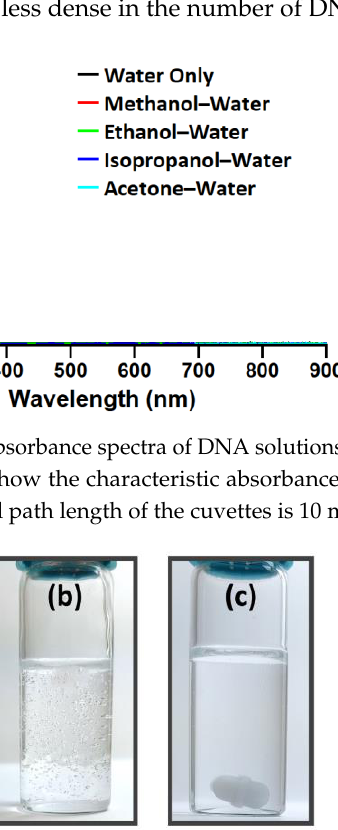
Figure 8. Pictures: ( a ) A highly homogeneous aqueous DNA solution. ( b ) The same volume of isopropanol is added into the sample of ( a ) with a vigorous quick shake. Bubbles in the entire solution and coalesced DNA at the top are present. ( c ) After 1 h of stirring of the sample of ( b ) with a magnetic stir bar, the DNA was dissolved homogeneously in isopropanol – water mixture.